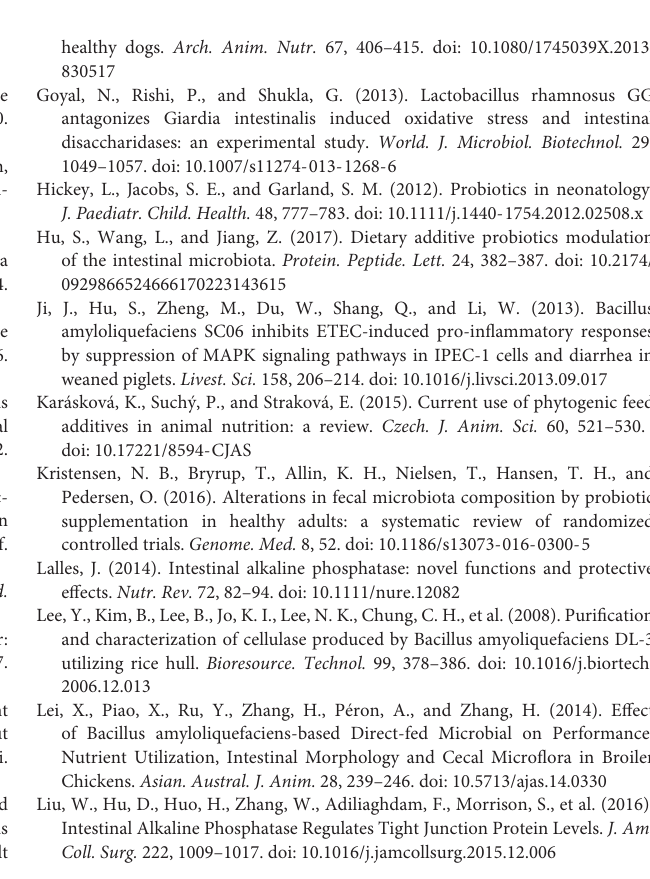
FIGURE S1 | The changes of gut bacterial phyla in different treatments. FIGURE S2 | The changes of gut bacterial genera in different treatments. TABLE S1 | Detailed data for the gut bacterial phyla. TABLE S2 | Detailed data for the gut bacterial